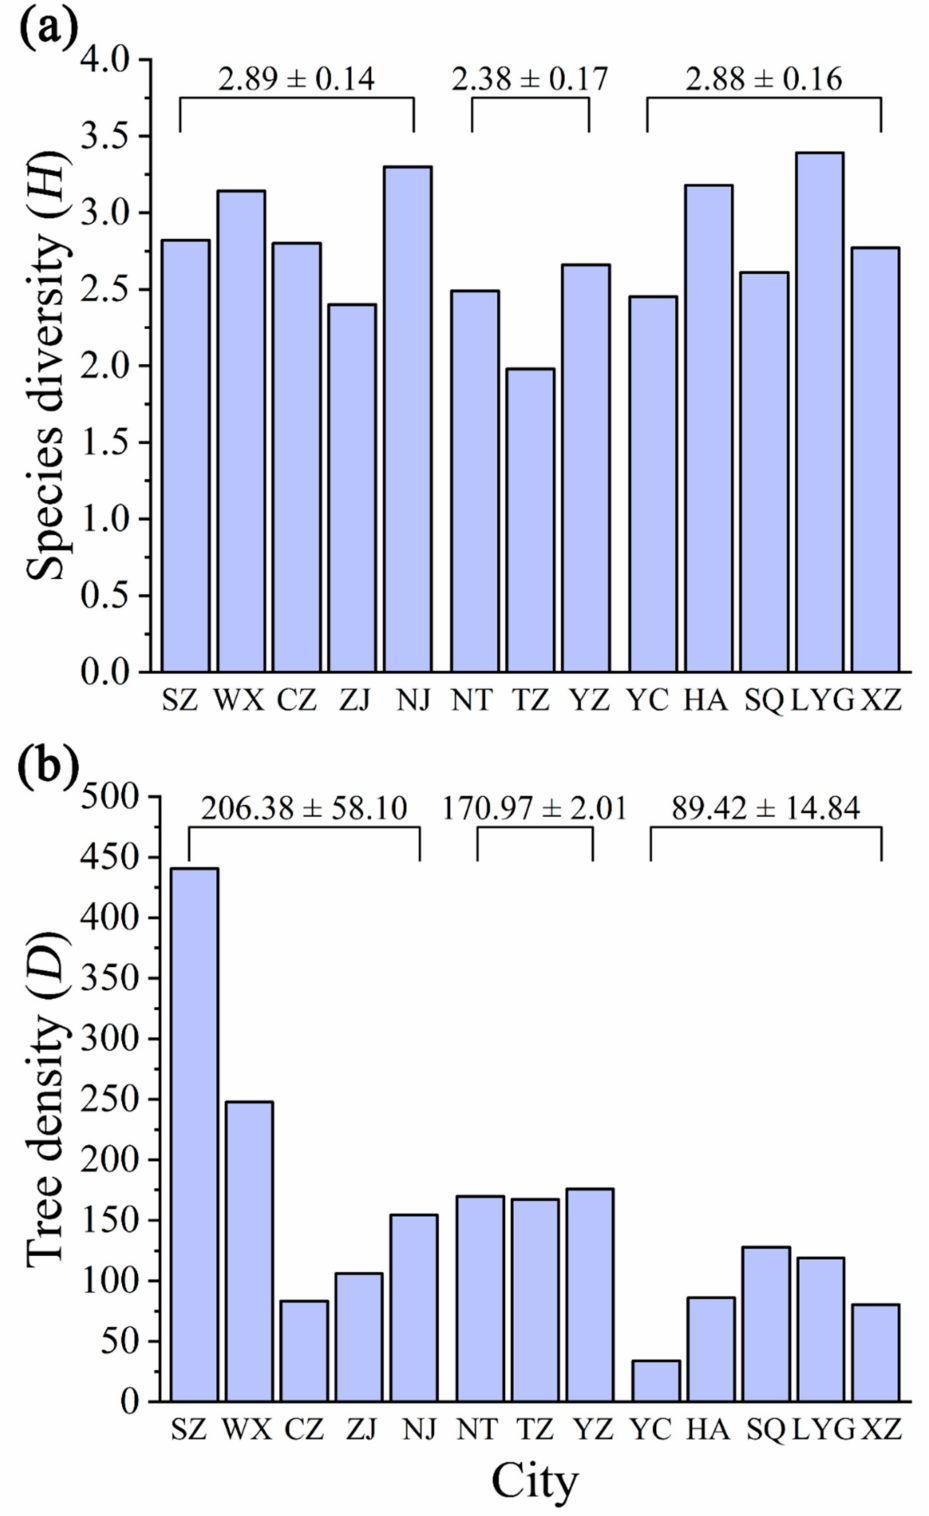
Figure 4. Comparison of spatial distribution by 13 cities in Jiangsu Province, eastern China: ( a ) species diversity and ( b ) tree density. The different data above the bars in ( a , b ) indicate the mean ± standard error of southern Jiangsu (including SZ, WX, CZ, ZJ, and NJ), central Jiangsu (NT, TZ, and YZ) and northern Jiangsu (YC, HA, SQ, LYG, and XZ), respectively. Refer to Table 1 for the meaning of the abbreviated